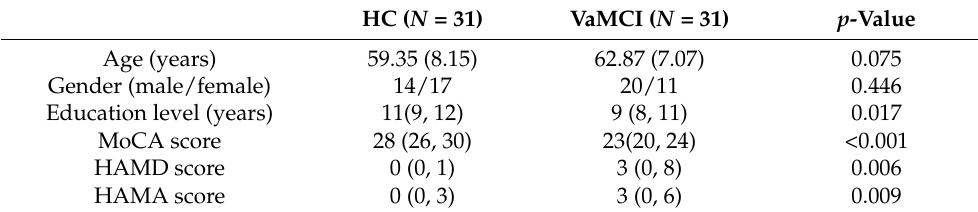
Table 1. Demographic and clinical characteristics.